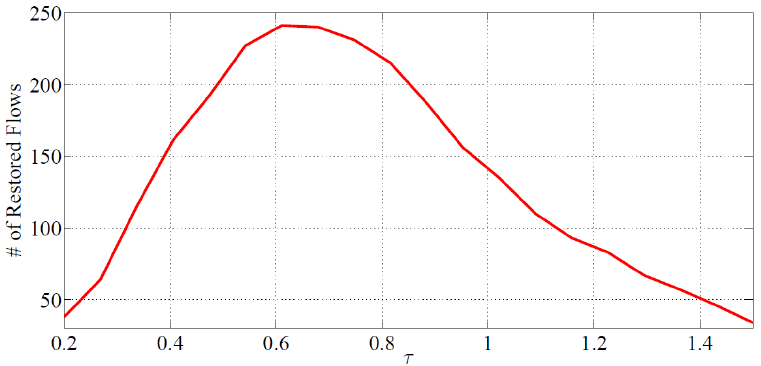
Figure 9. Number of restored flows versus risk threshold.